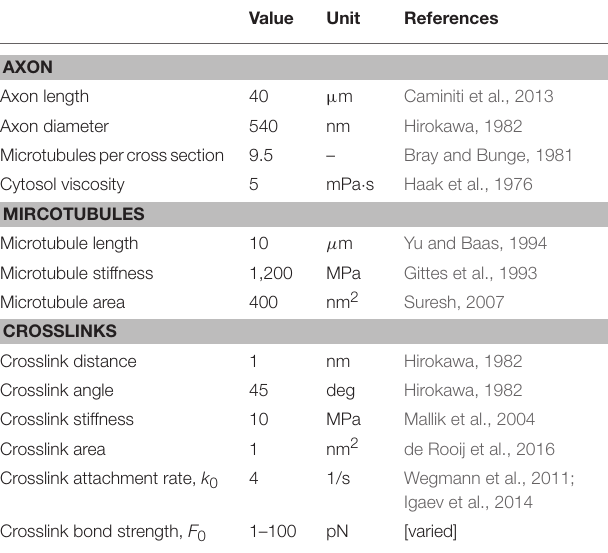
TABLE 1 | Parameters of the axon model, the microtubule model, and the crosslink model. Value Unit